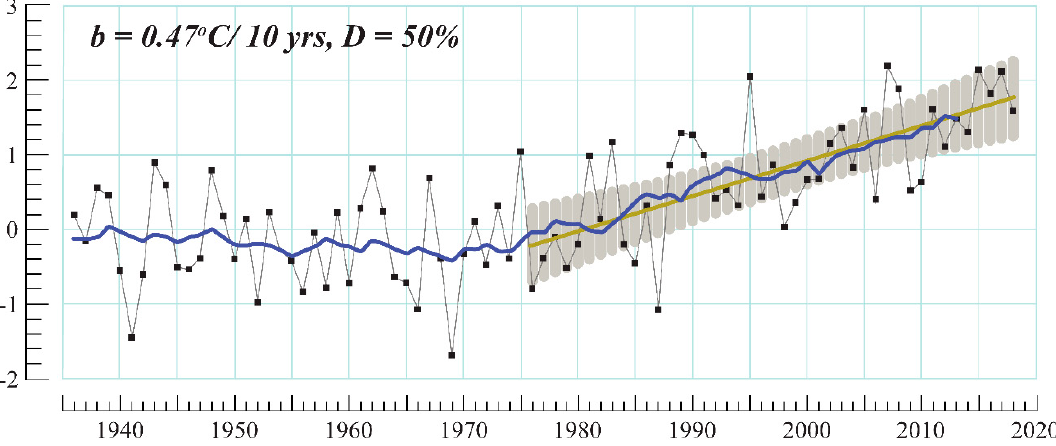
Figure 5. Average annual surface air temperature anomalies (°C), averaged over the territory of Russia, 1936–2018. Anomalies are calculated as deviations from the 1961–1990 mean. Also shown is the 11 year moving average and linear trend for 1976–2018 with 95% confidence band, where b is the trend coefficient (°C/10 years) and D% is the trend contribution to the total dispersion [51].